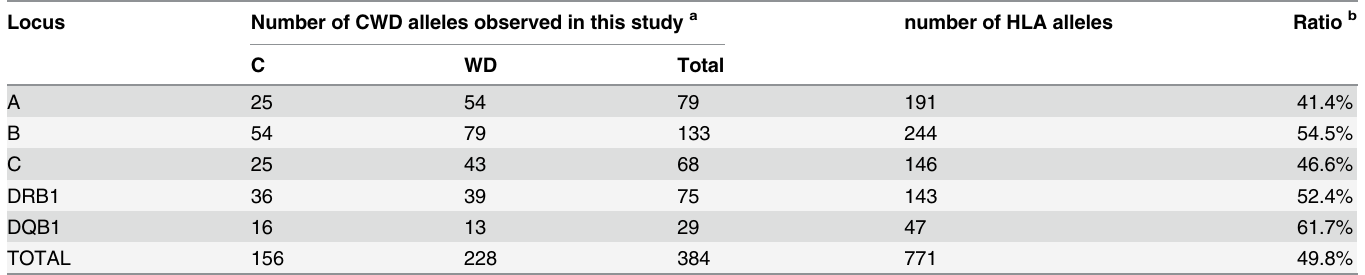
Table 3. Numbers of CWD alleles in 169,995 Chinese individuals. Locus Number of CWD alleles observed in this study